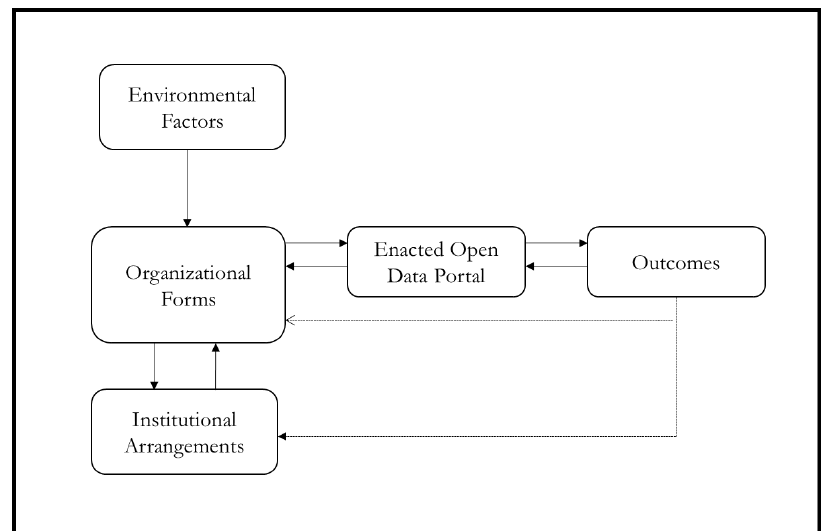
Figure 3: Open data enactment model